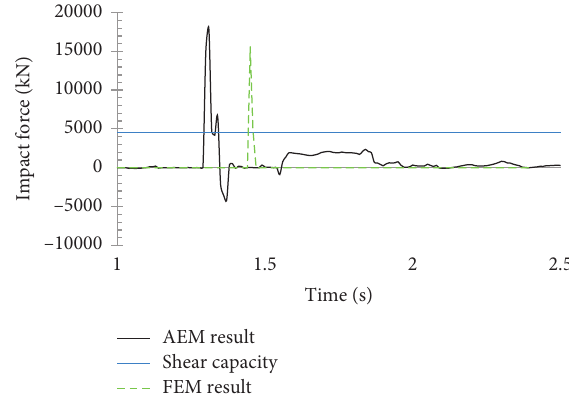
Figure 7: Comparison of the imposed impacting force on pier #109 of Hongqi Bridge